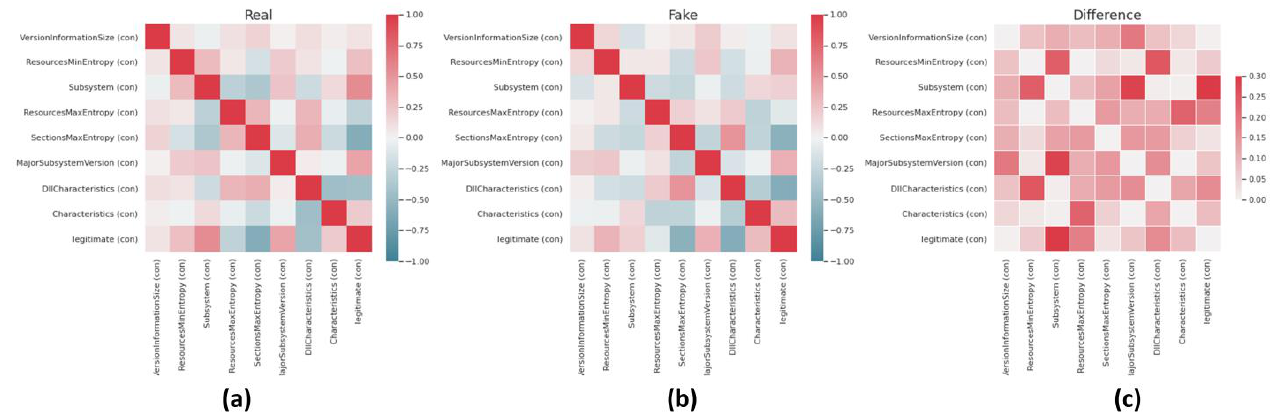
Figure 10. Correlation differences between features in original ( a ), generated ( b ) and between them ( c ).